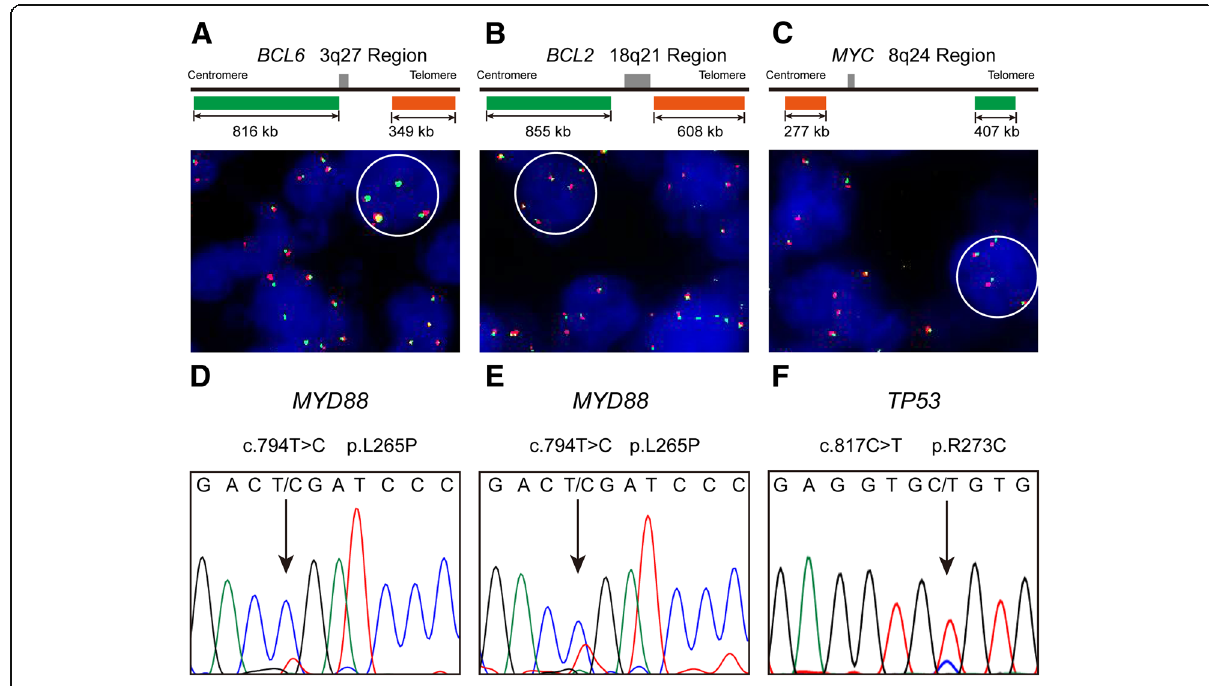
Fig. 2 Representative results of fluorescence in situ hybridization (FISH) analysis and Sanger sequencing of primary CNS A-DLBCL. The FISH analysis for patient 1 showed extra copy signals for BCL6 ( a ), BCL2 ( b ) and MYC ( c ). MYD88 L265P mutations in patients 1 ( d ) and 2 ( e ), in which a CTG (leucine) codon was changed to a CCG (proline) codon. TP53 R273C mutation of patient 3 ( f ), in which a CGT (arginine) codon was changed to a TGT (cysteine)